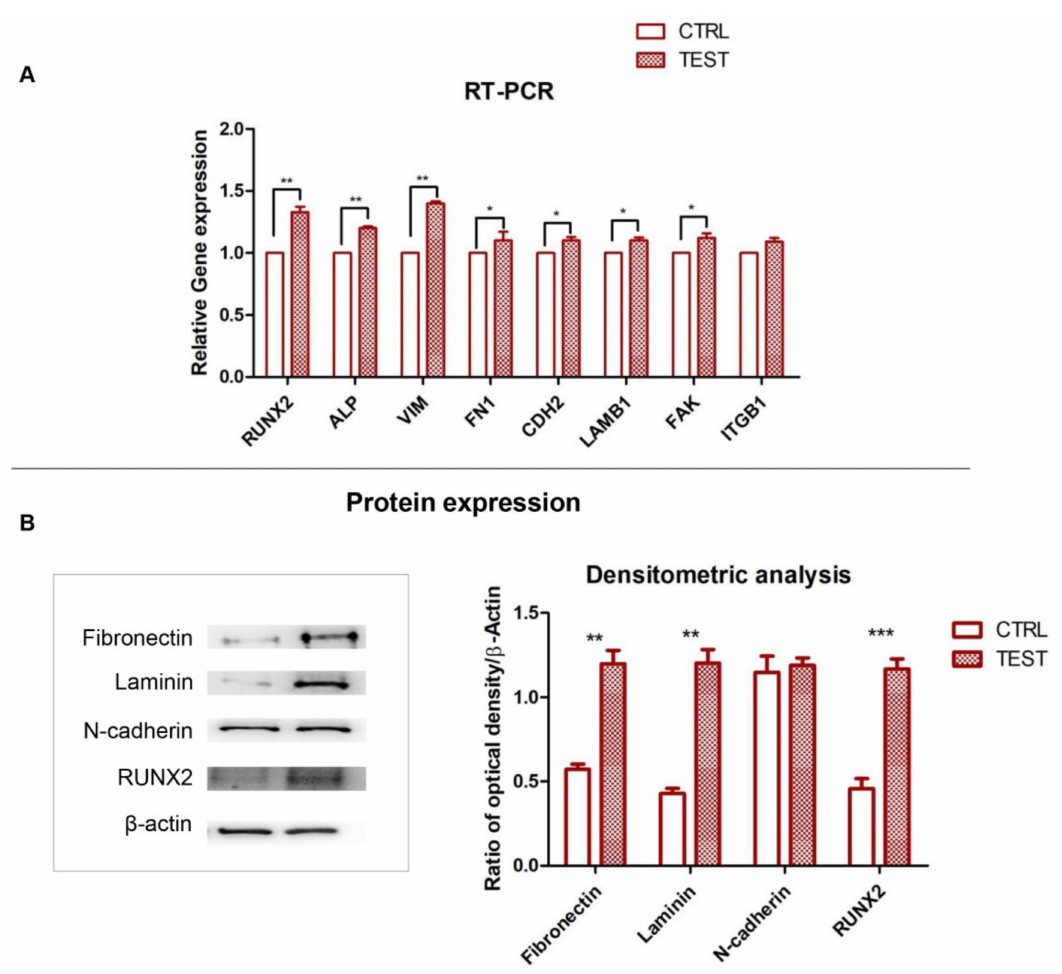
Figure 6. ( A ) Graph of RT-PCR showed the mRNA levels of RUNX2, ALP, VIM, FN1, CDH2, LAMB1, FAK and ITGB1 in cells cultured on CTRL and TEST surface. * p < 0.05; ** p < 0.01. ( B ) Protein level expression of Fibronectin, Laminin, N-cadherin and RUNX2 in cells cultured on CTRL and TEST surface. β -actin was used as a housekeeping protein. Graph bars represent the densitometric measurements of proteins bands expressed as integrated optical intensity with the mean of three separate experiments. The error bars in these graphs showed the standard deviation ( ± SD). Densitometric values analysed by ANOVA showed significant differences. ** p < 0.01; *** p < 0.001. Please refer to Full Western blot in